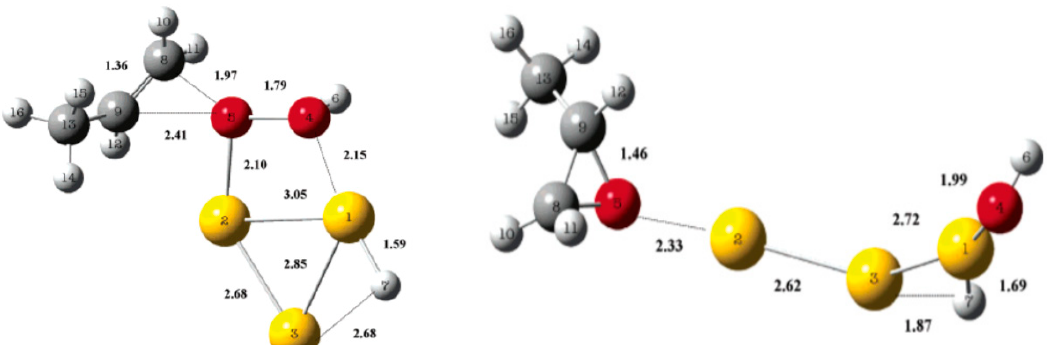
Figure 7. Structures of the transition state and final product during the epoxidation step on Au 3 . Distances are in angstroms [119]. Copyright © 2006 American Chemical Society.